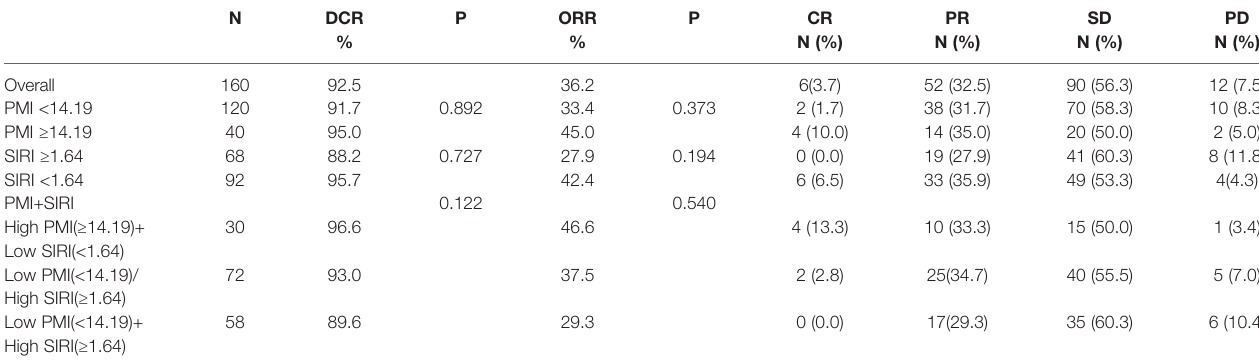
TABLE 2 | Tyrosine kinase inhibitors and immune checkpoint inhibitors ef fi cacy